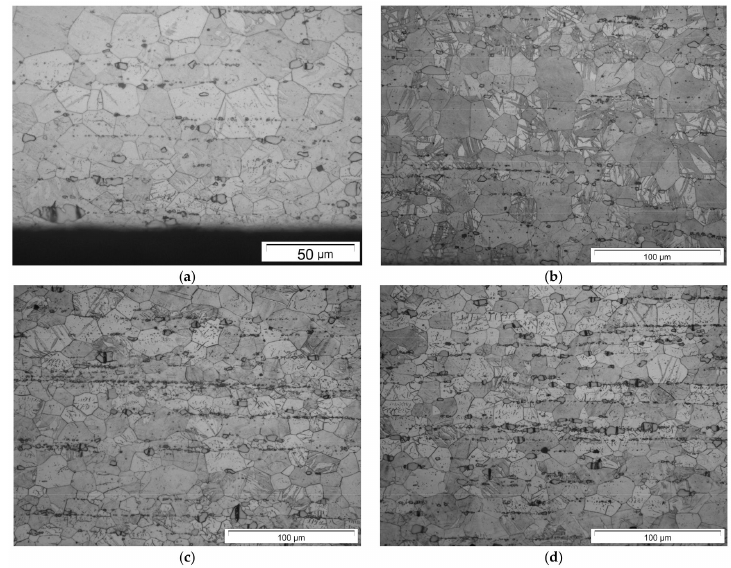
Figure 8. Crack initiation at brittle secondary particles in extruded Mg10Gd1Nd1La: ( a ) tension side at 8% outer strain; ( b ) compression side at 10% outer strain; ( c ) tension side at 10% outer strain; and ( d ) tension side at 12% outer